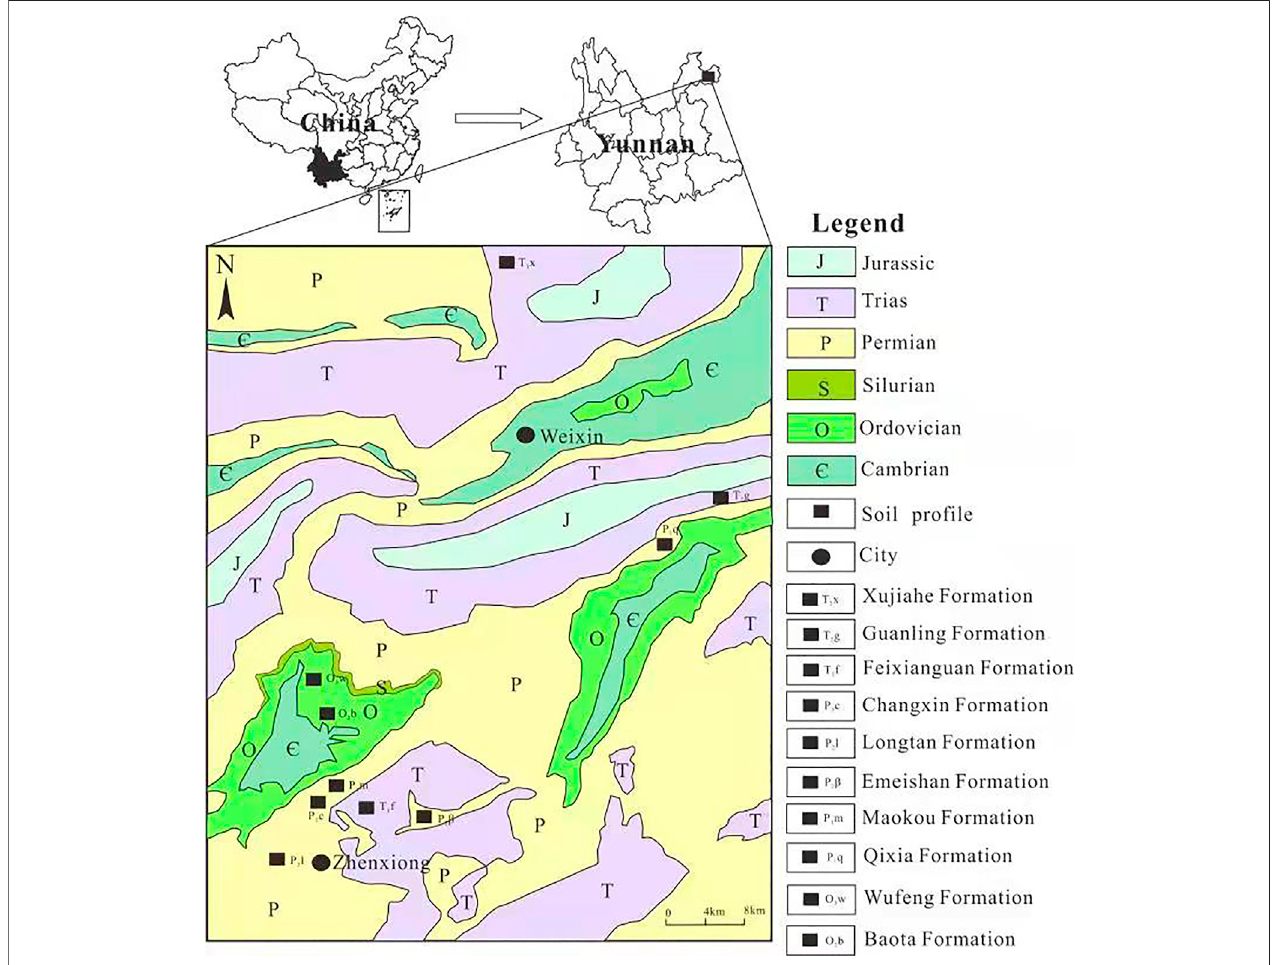
FIGURE 1 | Geological map and sampling location.